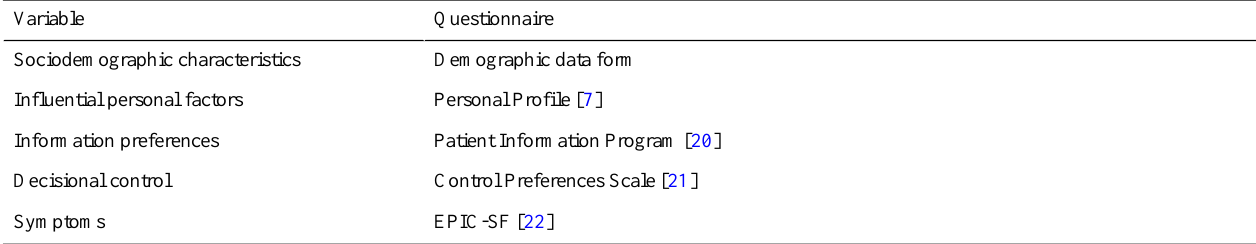
Table 1. Variables and questionnaire results used to generate the P3P tailored intervention